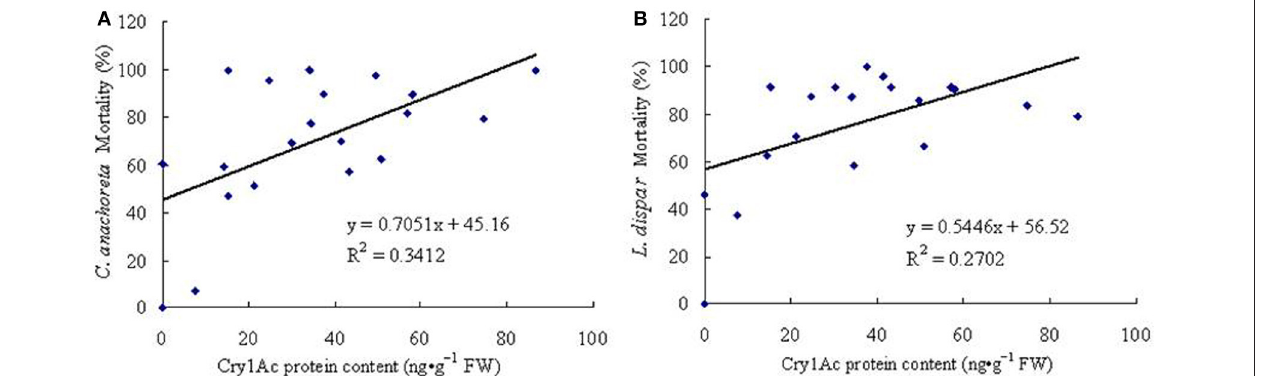
FIGURE 8 | Correlations between insect mortality rates and Cry1Ac protein content of 19 6-year-old transgenic lines. (A) Correlation between C. anachoreta mortality rate and Cry1Ac protein content of 19 6-year-old transgenic lines. (B) Correlation between L. dispar mortality rate and Cry1Ac protein content of 19 6-year-old transgenic lines. Each figure uses the toxin protein content of 19 transgenic lines (abscissa) and the mortality rate of insect larvae (ordinate) to make a scatterplot. In the end, a fitted linear equation was obtained according to the coordinates of points in the